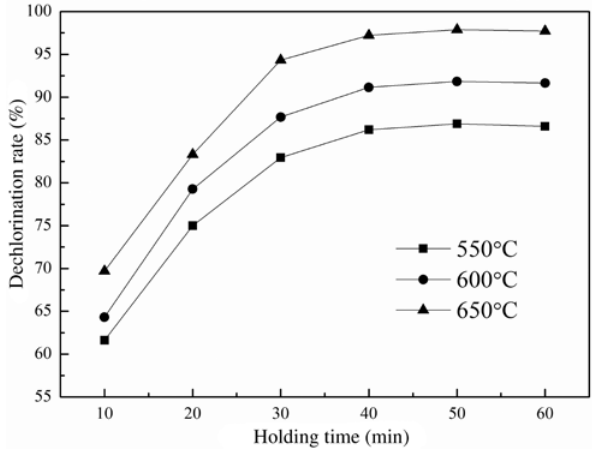
Figure 8: Effects of temperature on dechlorination rate.